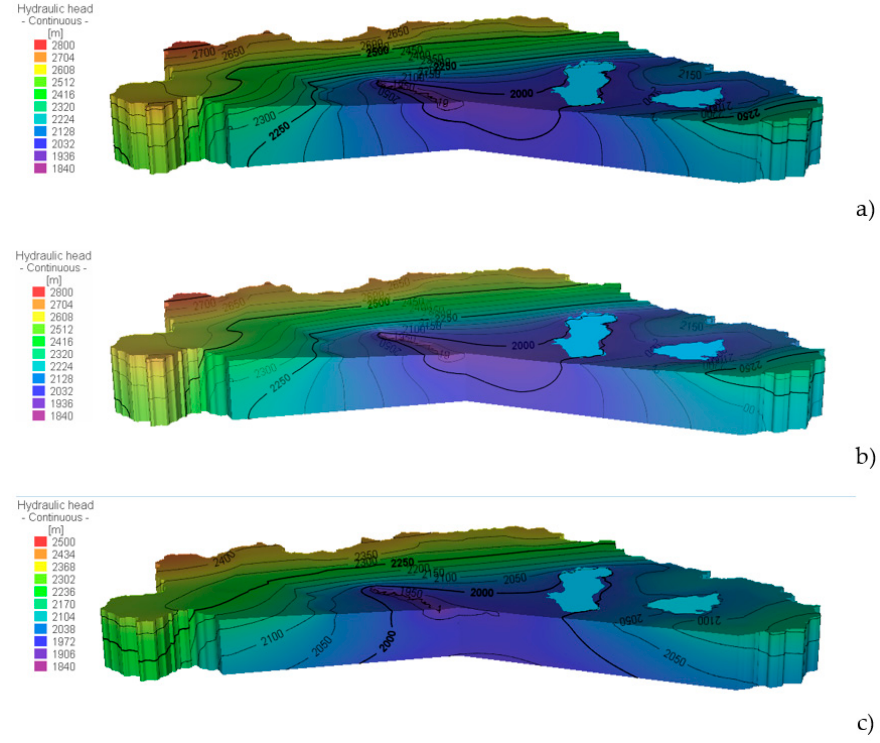
Figure 5. Hydraulic head distribution in the 3D domain: ( a ) topography-driven groundwater flow